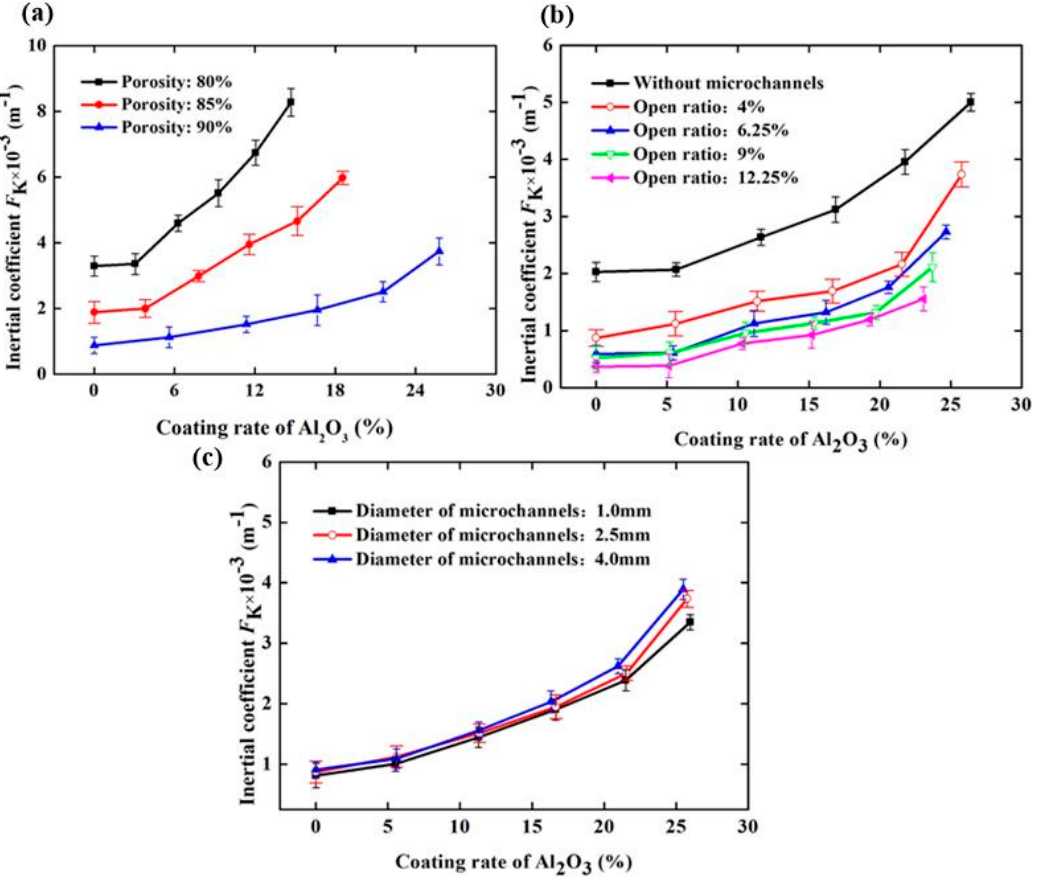
Figure 12. Inertial coefficient of SCSSFFC/Al 2 O 3 with different Al 2 O 3 coating rates under different structural parameters of SCSSFFC: ( a ) porosity ( α = 4%, d = 2.5 mm); ( b ) open ratio ( ε = 90%, d = 2.5 mm); ( c ) diameter of microchannel ( ε = 90%, α = 4%).